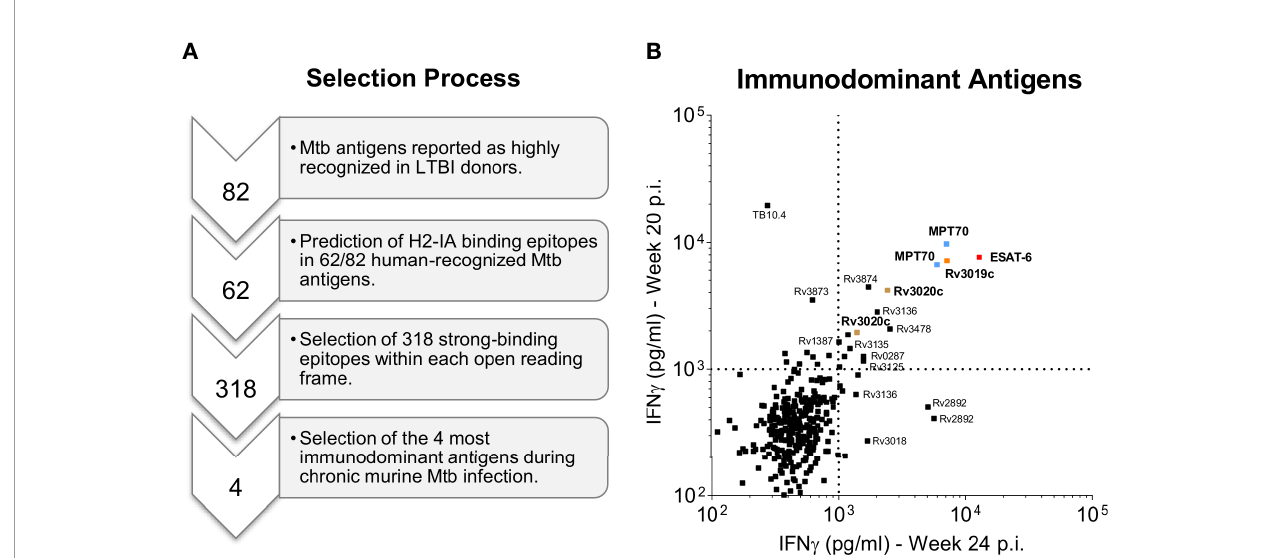
FIGURE 1 | Selection of immunodominant antigens during chronic Mtb infection. (A) A pre-selection of Mtb antigens were performed on the basis of two previous genome-wide epitope screening studies in human LTBI donors (33, 37). A total of 62 Mtb antigens were selected and in silico predicted for the presence of murine CD4 T cell epitopes using the NetMHCII 2.3 Server (39). The computational screening resulted in 318 potential murine CD4 T cell epitopes that were synthesized as 17-mer peptides ( Supplementary Table 1 ). Finally, the four most immunodominant antigens were selected based on high CD4 T cell recognition of the synthesized Mtb peptides by CB6F1 mice during late chronic Mtb infection (20 and 24 weeks post challenge) as presented in b. (B) In two independent experiments splenocyte culture supernatants were harvested after 3 days of culture with individual peptides and the level of IFN- g was measured. The top four immunodominant antigens (1 st quadrant) are highlighted in bold and color coded: MPT70 (Rv2875): blue, ESAT-6 (Rv3875): red, Rv3020c: brown and Rv3019c: orange. Each squared dot represent a single peptide